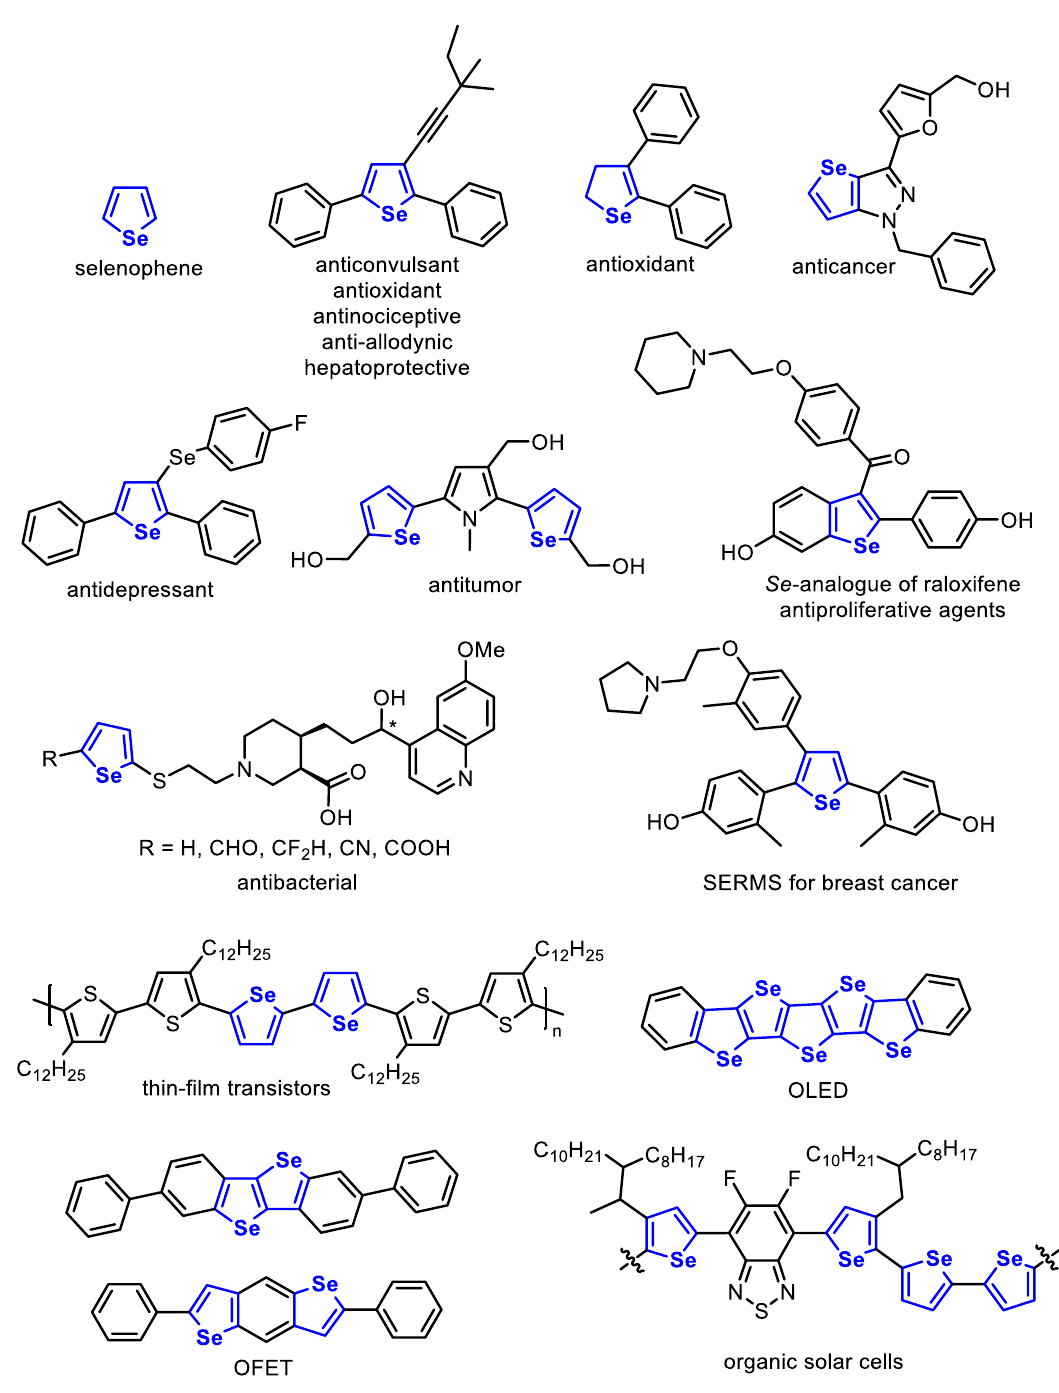
Figure 1. Selected examples of biologically active and technologically interesting selenophenes.